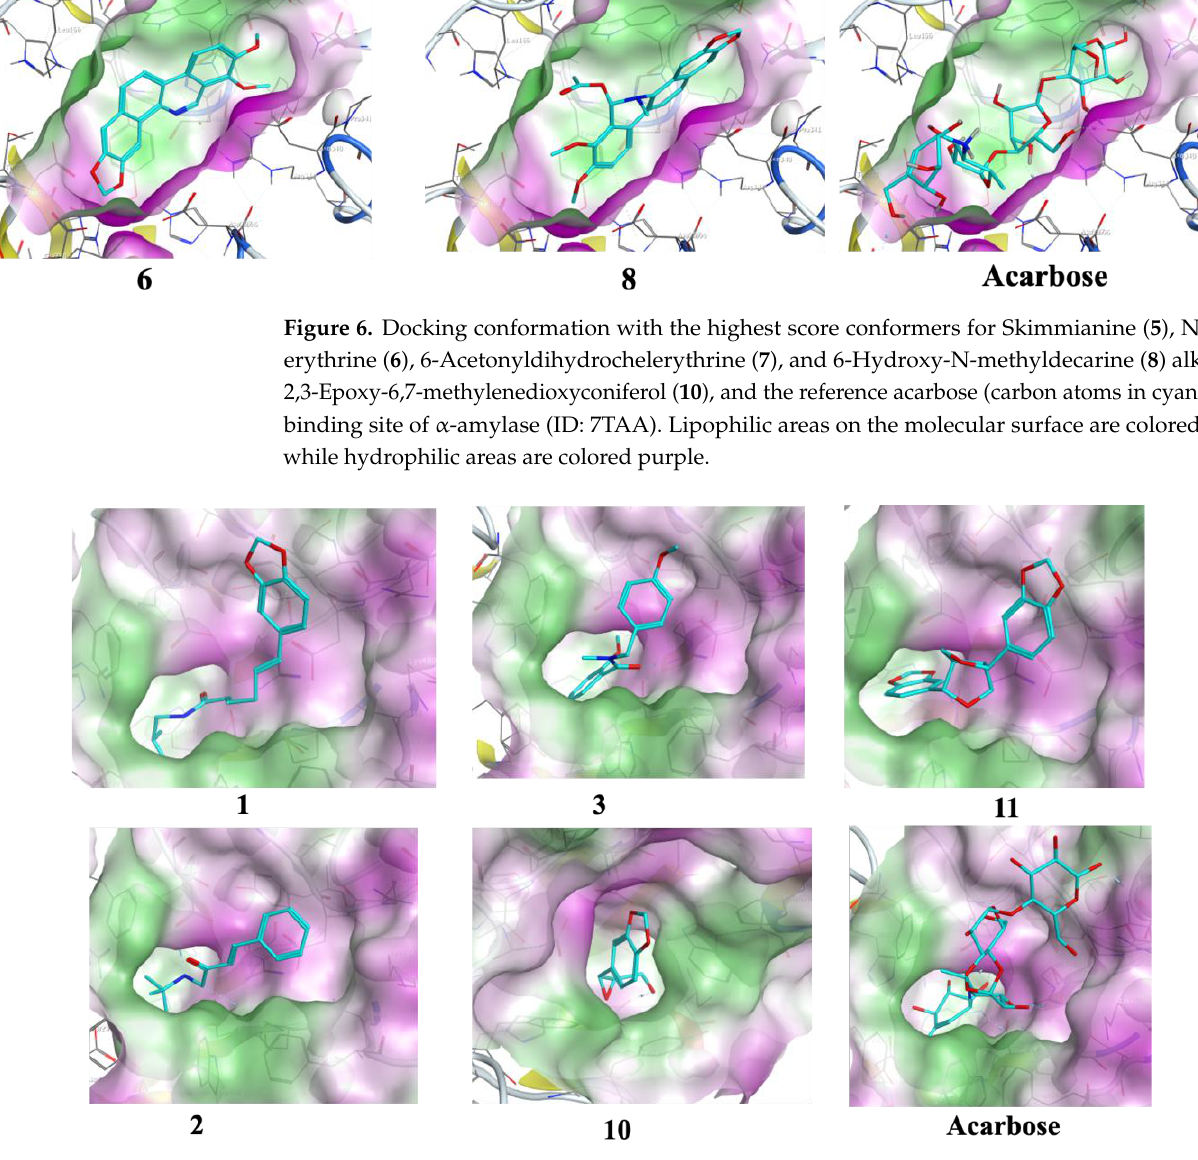
Figure 7. Docking conformation with the highest score conformers for chaylbemide A ( 1 ), chalybeate B ( 2 ) and chalybemide C ( 3 ), 2,3-Epoxy-6,7-methylenedioxyconiferol ( 10 ), sesame ( 11 ), and the reference acarbose (carbon atoms in cyan) in the binding site of α -glucosidase (ID: 2QMJ. Lipophilic areas on the molecular surface are colored green, while hydrophilic areas are colored purple.